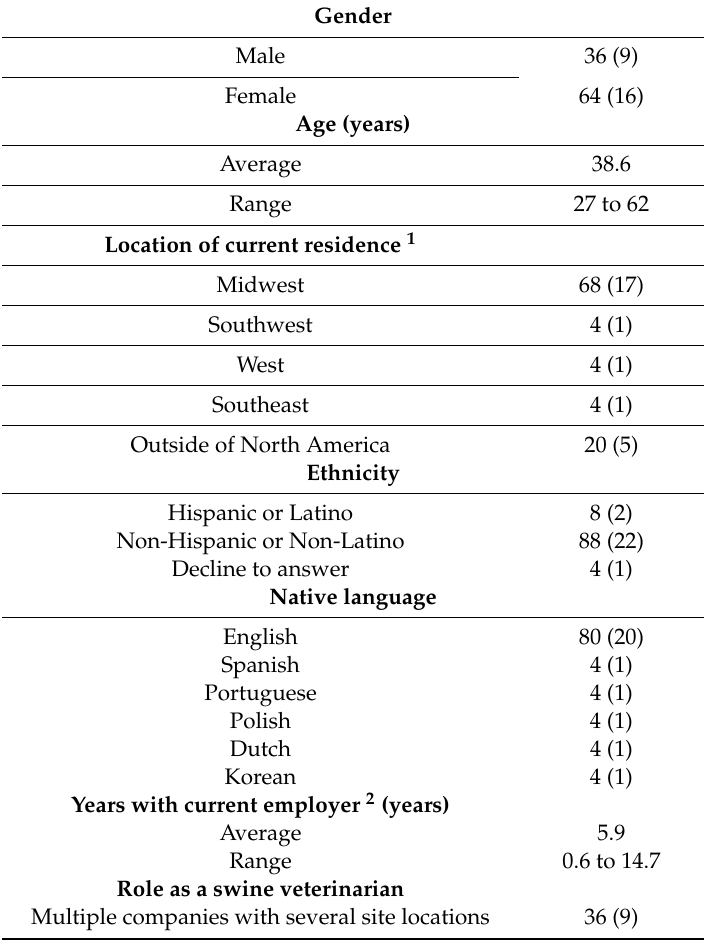
Table 1. Demographics of survey respondents ( n =